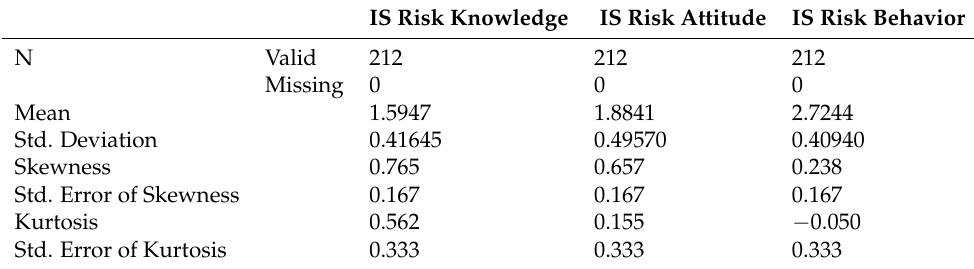
Figure 2. Distribution of knowledge, attitude and behavior of security practice. Table 2. Skewness of IS security